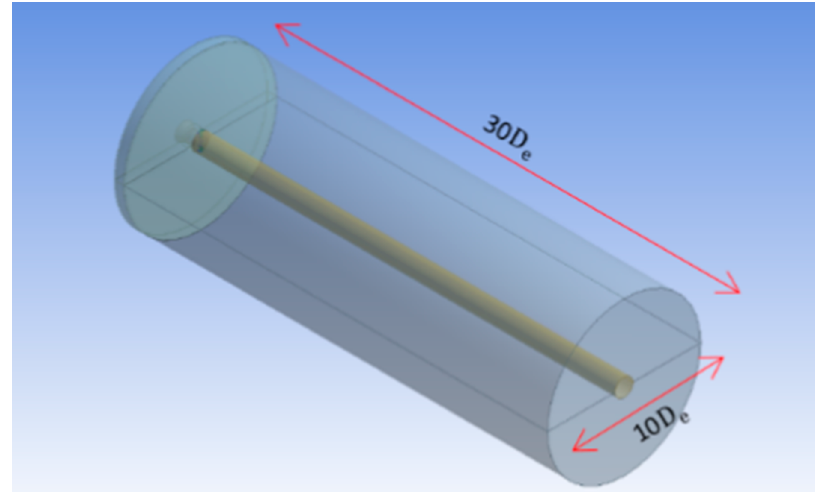
Figure 1. Mach 1.8 convergent-divergent nozzle with short rectangular tabs employed at the nozzle exit.